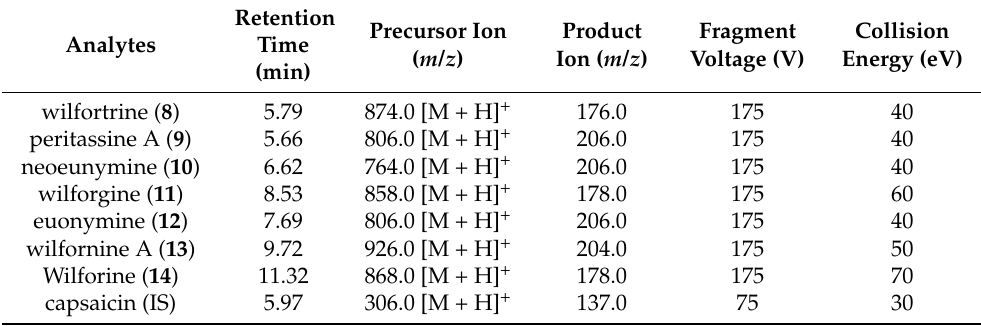
Table 2. Retention time and related MS parameters for investigated sesquiterpene alkaloids and